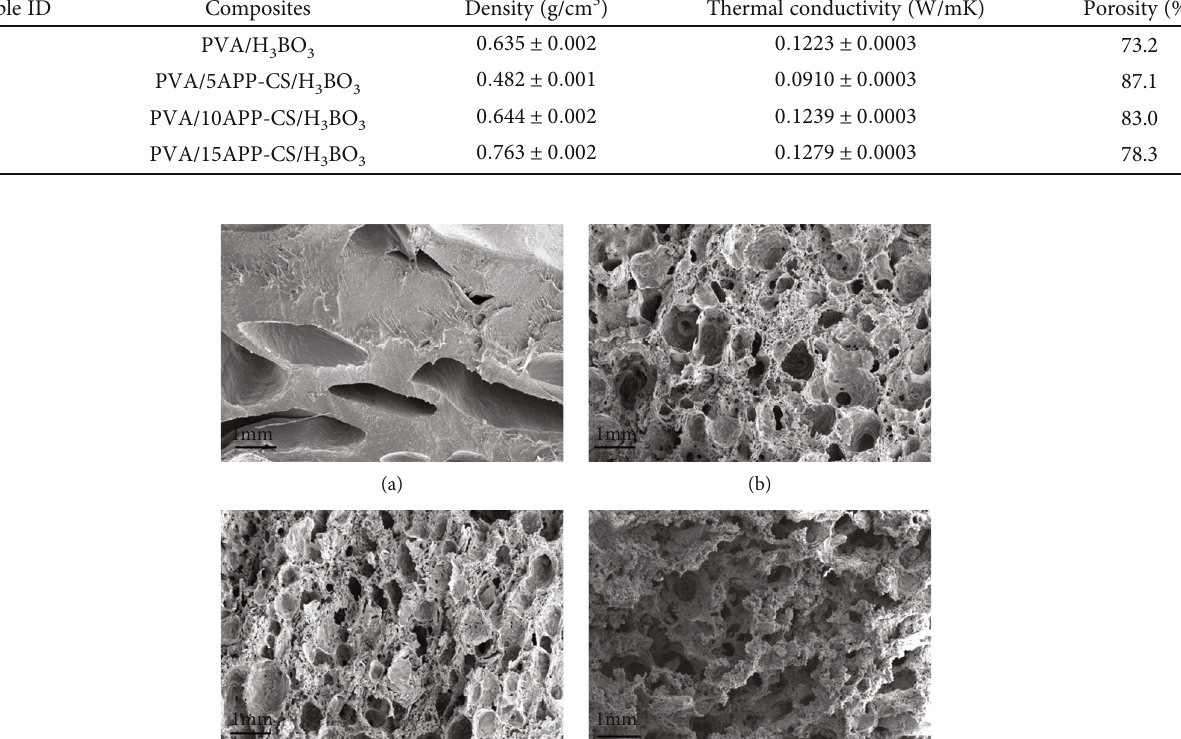
BO , (c) PVA/10APP-CS/H 3 3